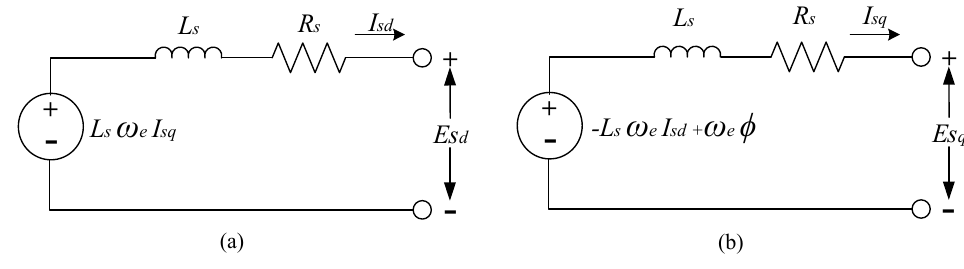
Figure 8. Equivalent circuit of PMSG in: ( a ) d -axis and ( b ) q -axis.